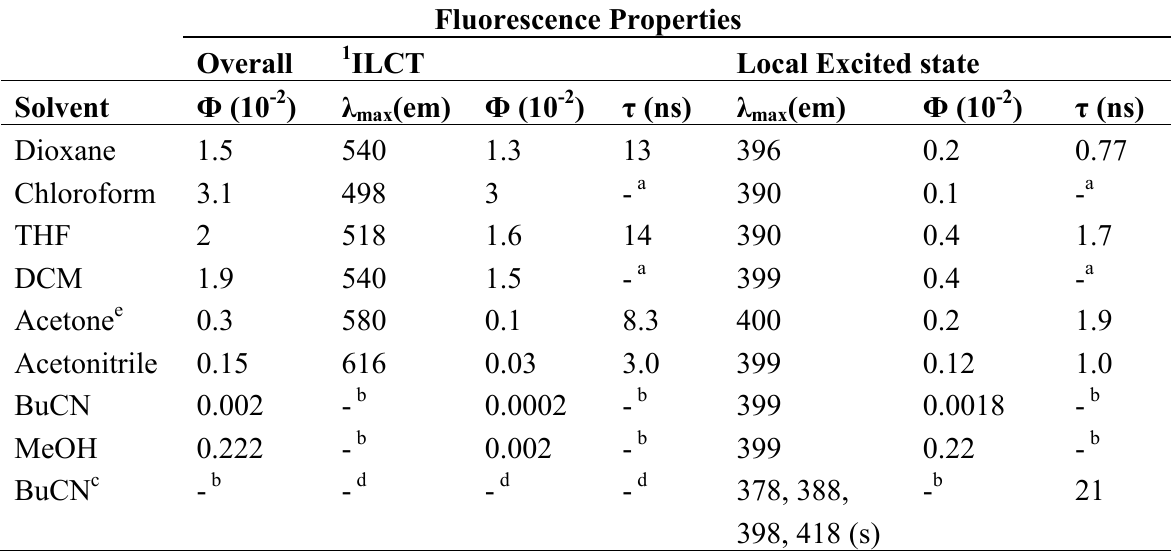
Table 4. Fluorescence properties Zn(TpyPhPyrene emission maximum, Ф is the luminescence quantum yield and τ is the luminescence = 310 lifetime) (  ex